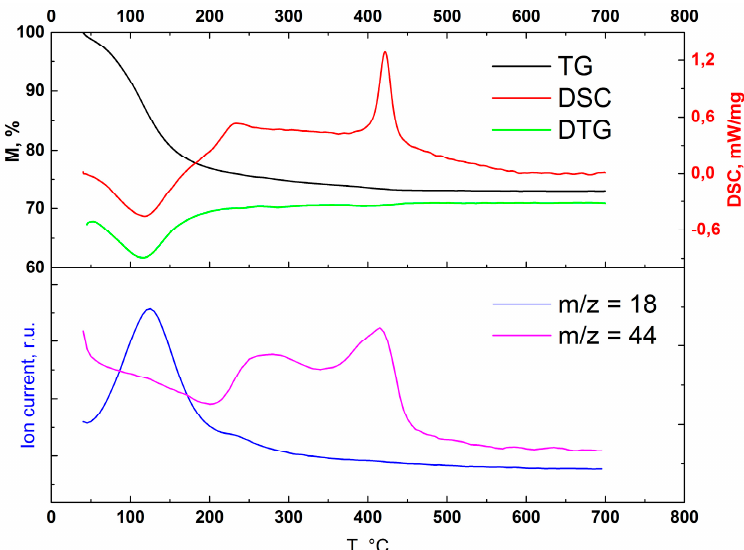
Figure 9. TG–DTG–DSC of untreated amorphous microspheres (upper picture) and MS-curves for evolved gases (lower picture). TG: thermogravimetry; DTG: derivative thermogravimetry; DSC: differential scanning calorimetry.